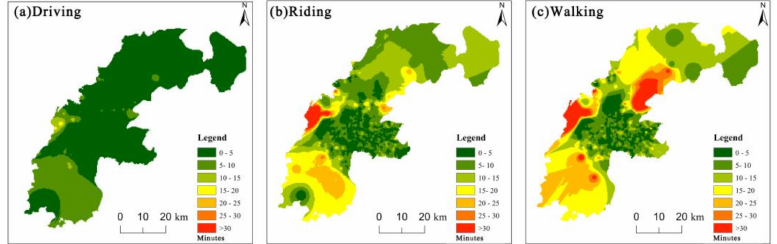
Figure 13. The map of accessibility before the epidemic: ( a ) driving; ( b ) riding; ( c ) walking.